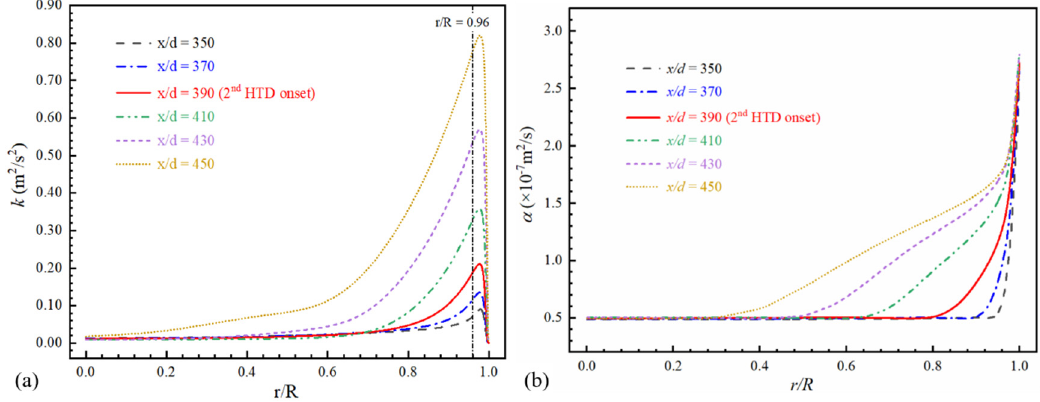
Figure 13. Radial distributions of turbulent kinetic energy ( a ) and thermal diffusion coefficient ( b ) in the second HTD zone. the second HTD zone.